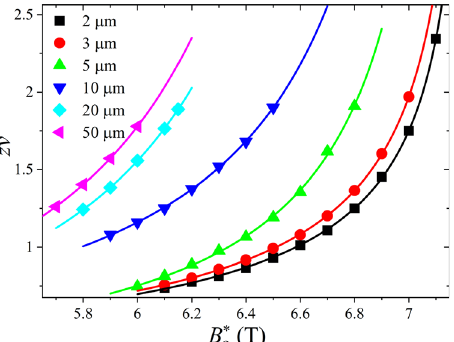
Fig. 6 The scaling behavior of the product of the correlation length and dynamical exponents z ν as a function of the re-entrance fi eld to superconductivity B (cid:6) for narrow bridges. The solid lines represent fi ts (cid:3) (cid:4) c (cid:3) v Ψ , with B F (cid:3) B (cid:6) ¼ according to the activated scaling law z ν ¼ C (cid:5) B F c c c 7 : 25T the Fermi insulator quantum critical fi eld, v Ψ the critical-exponent product characterizing the divergence at a quantum Grif fi ths singularity, and C a depth, which is Λ 0 ð Þ ≈ 350 μ m in our case 36,37 . For an in fi nitely large 2D superconducting thin fi lm in a strong magnetic fi eld,